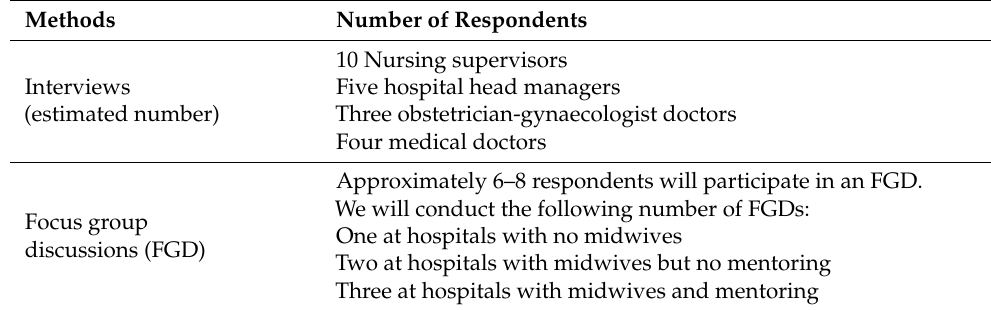
Table 4. Qualitative data collection methods and